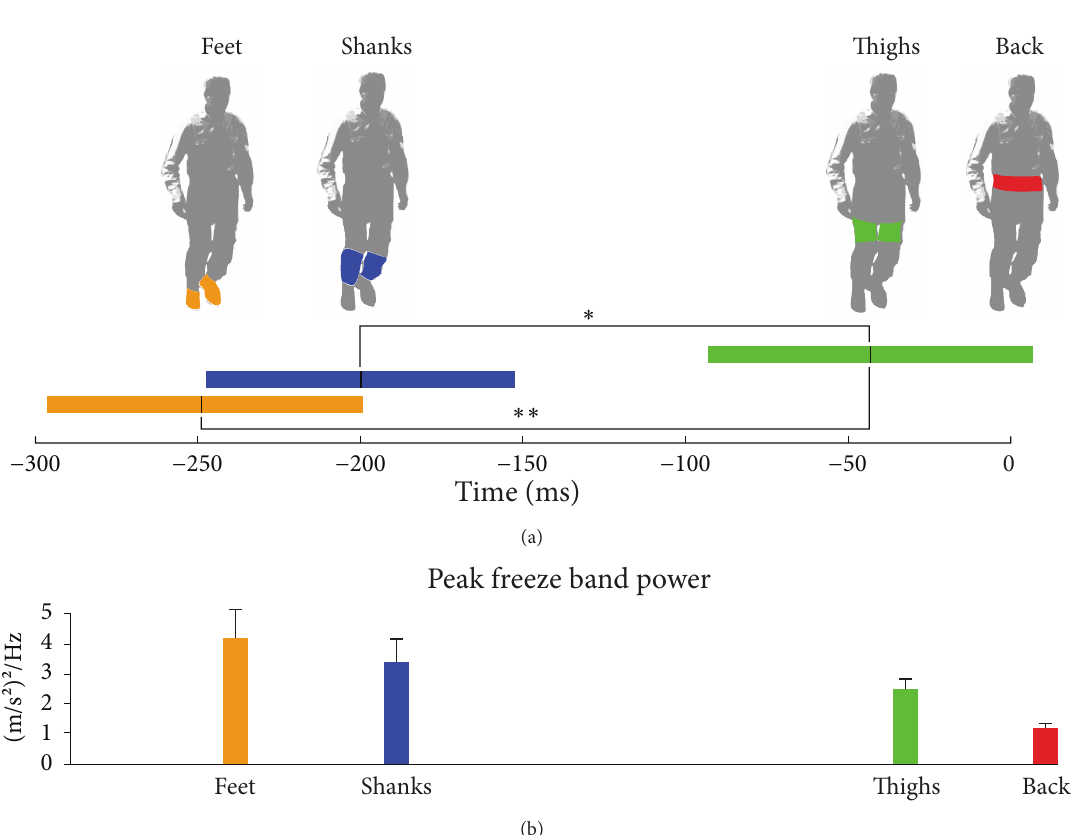
Figure 2: (a) Onset of lower limb freeze band activity relative to the back sensor (mean and SEM of both limbs). High frequency (3–8 Hz) oscillation occurred first in the feet, shanks, thighs, and then back, over a period of 250 ms. (b) Peak power (mean and SEM) decreased from the distal to proximal